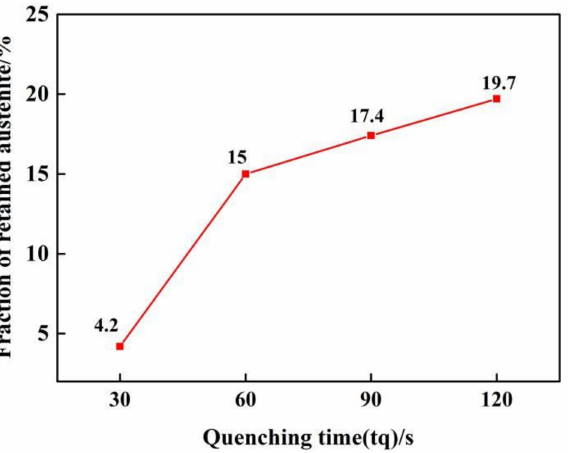
Figure 7. Changes in fraction of RA in the microstructure under different tq.